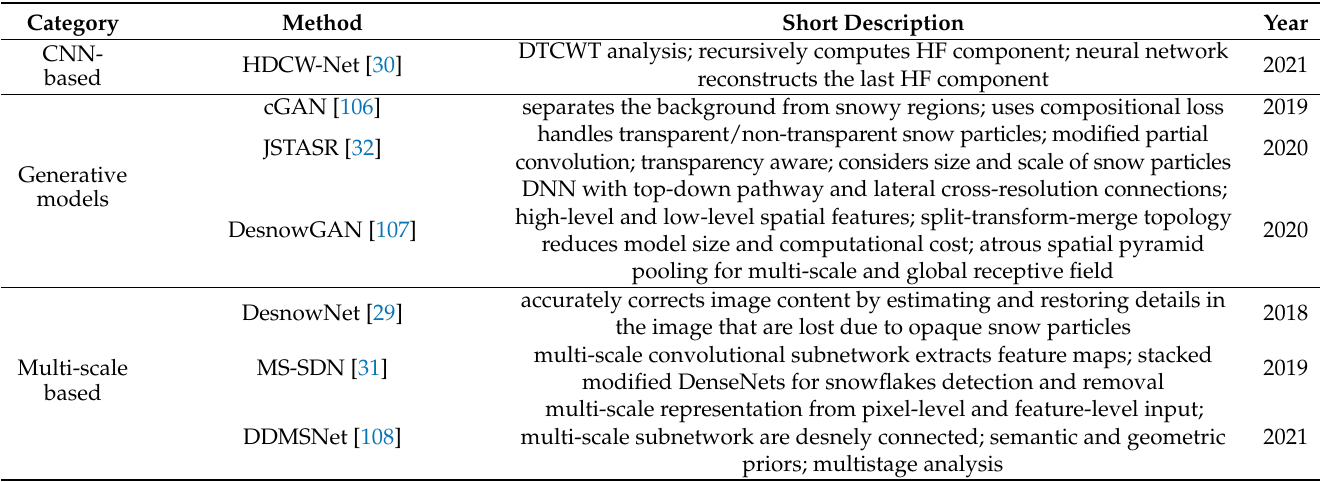
Table 5. Listing of references on the desnowing